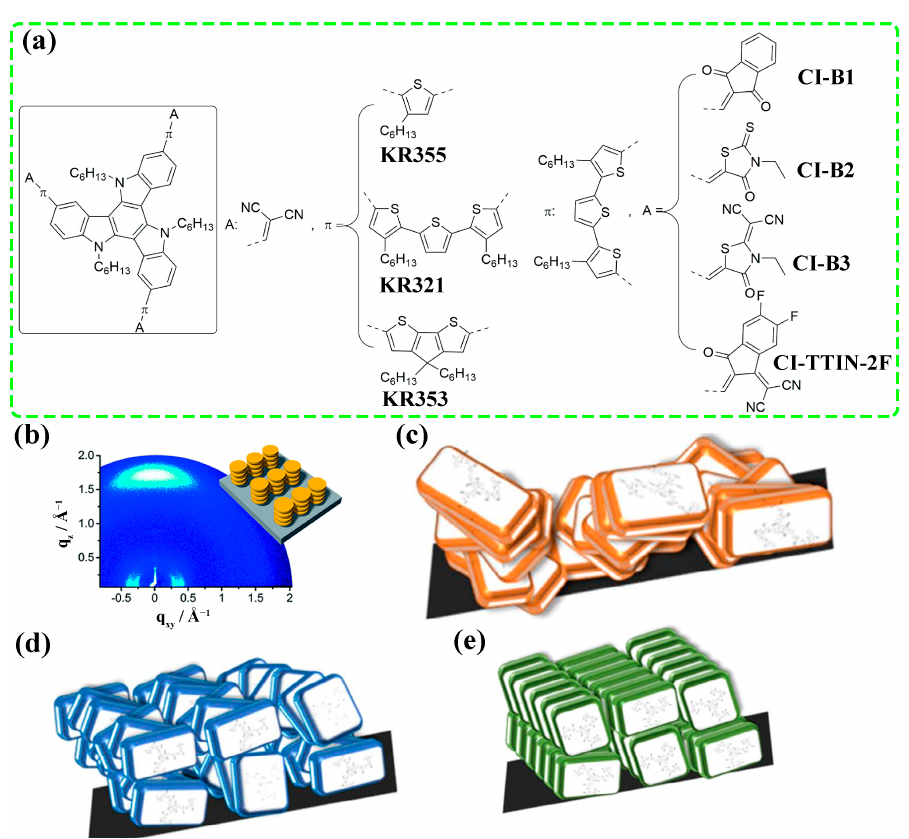
Figure 9. ( a ) Molecular structures of HTMs based on triazatruxene core. ( b ) GIWAXS pattern and surface stacking of the KR321 film on a silica wafer. Adapted with permission from Ref. [109]. Copyright 2017 The Royal Society of Chemistry. Surface stacking of CI-B1 ( c ), CI-B2 ( d ), and CI-B3 ( e ) on silica wafer. Adapted with permission from Ref. [61]. Copyright 2020 John Wiley and Sons.